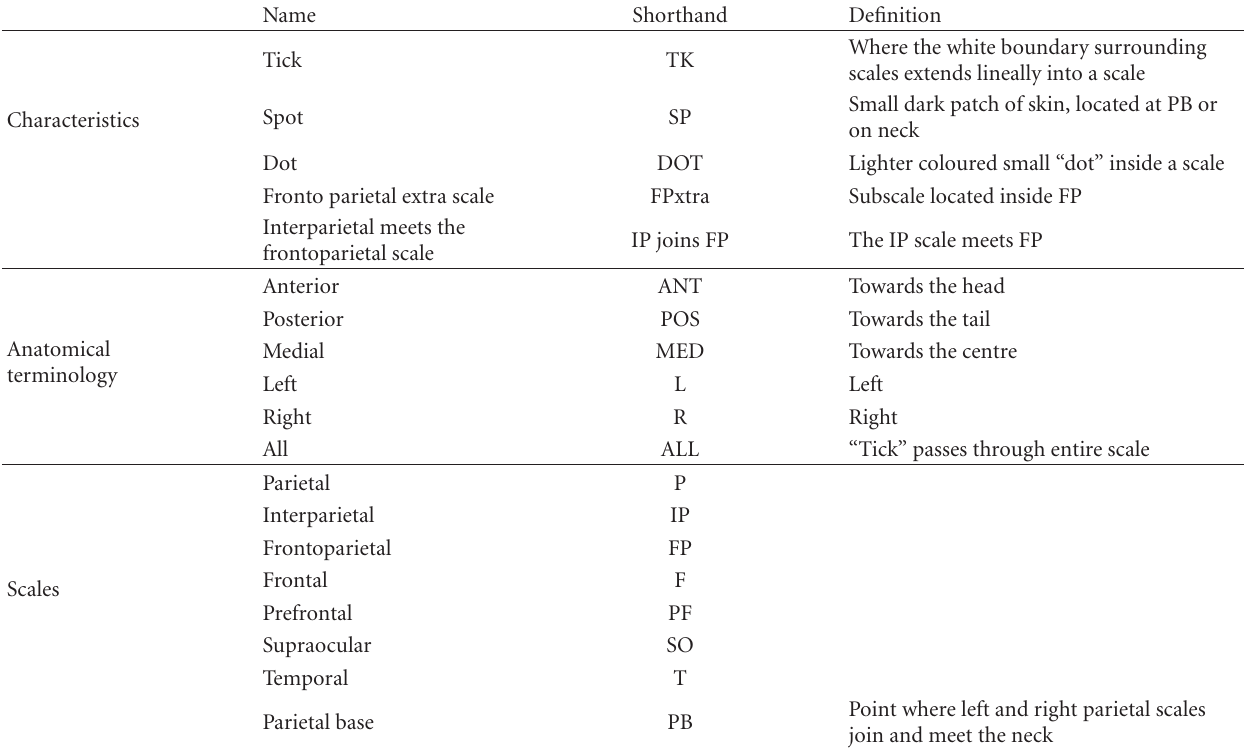
Table 1: Definitions of scale characteristics, anatomical terminology, and short hand used.